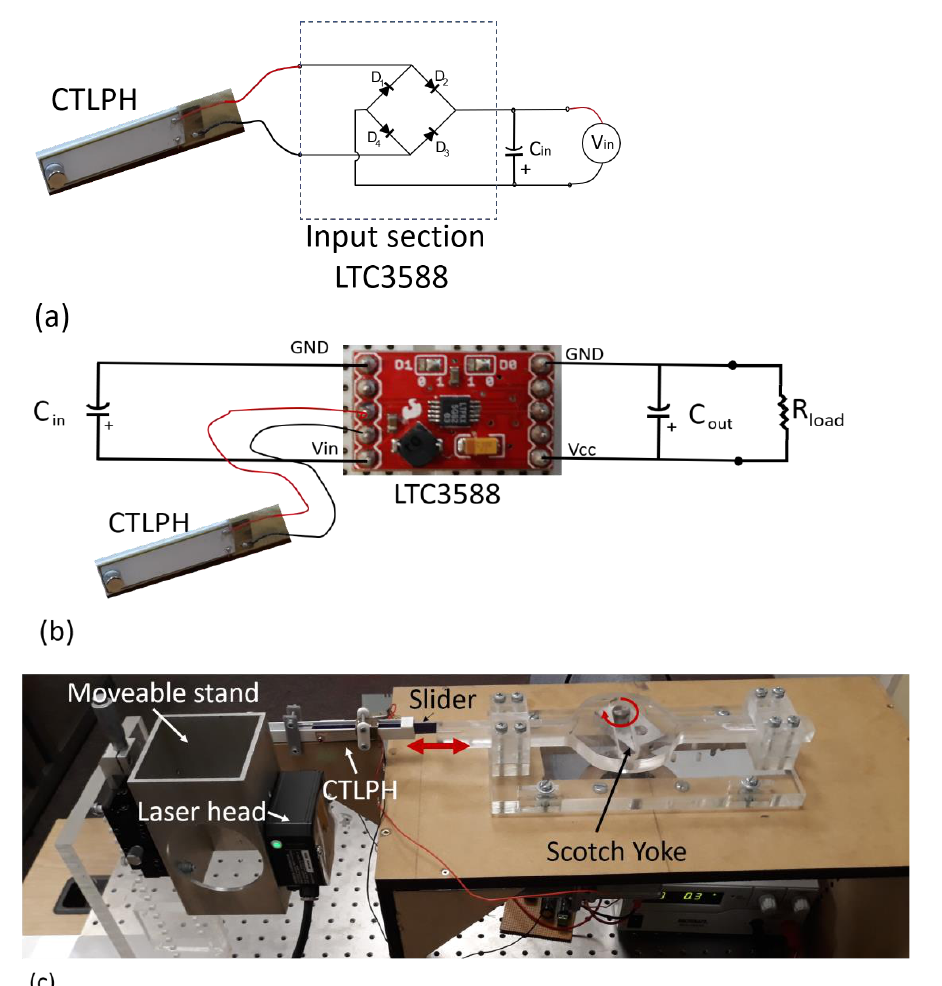
Figure 3. Performance evaluation. ( a ) Germanium diode bridge (1N34A) of the input section of LTC3588. ( b ) Connection of energy regulator module, LTC3588. ( c ) Driving and measurement setup.